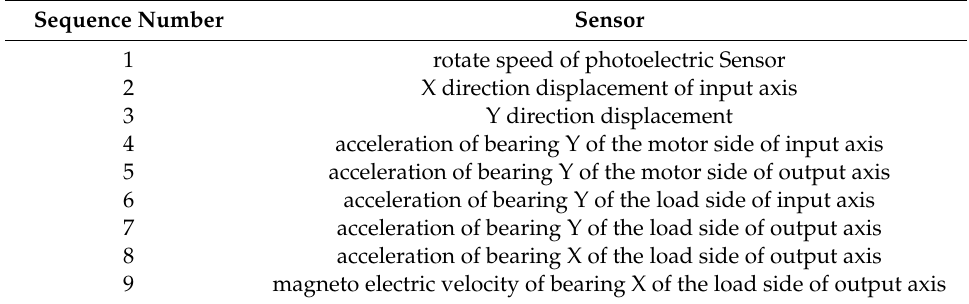
Table 2. Details of sensors equipped on the gearbox.